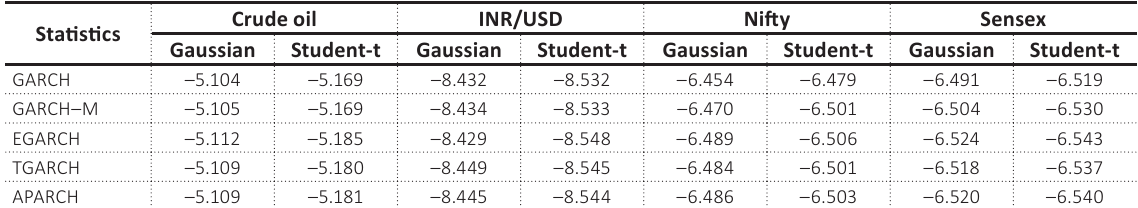
Table A2. SIC value comparison of different models under Gaussian and Student-t